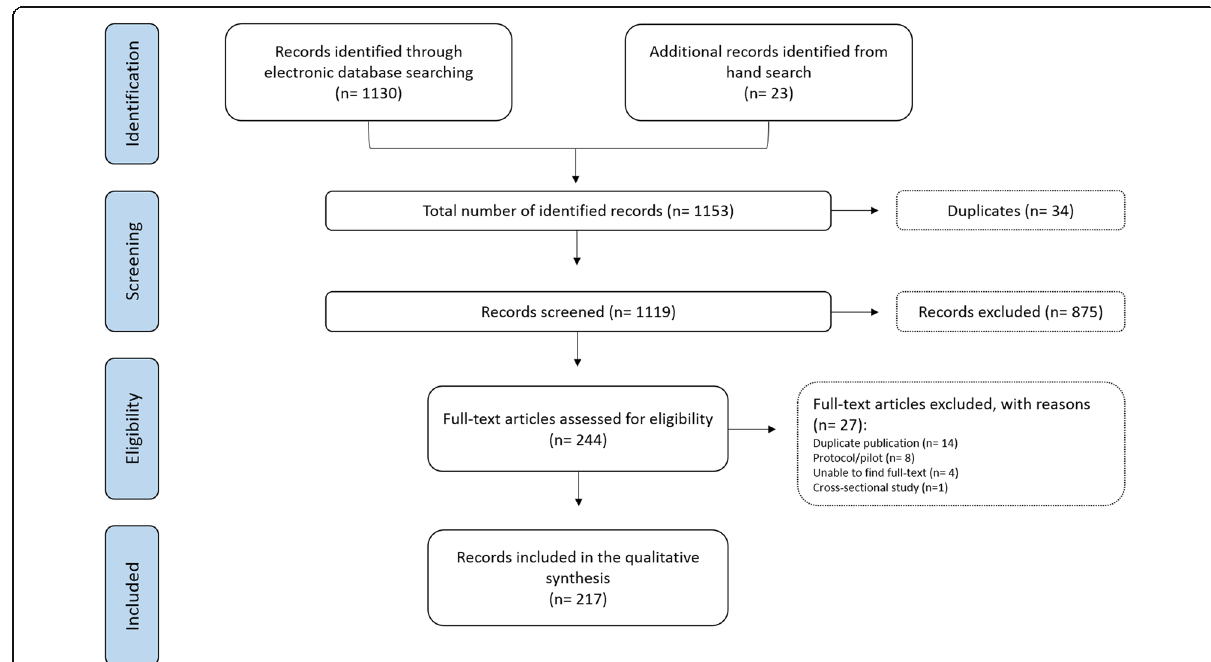
Fig. 1 PRISMA flowchart of included studies